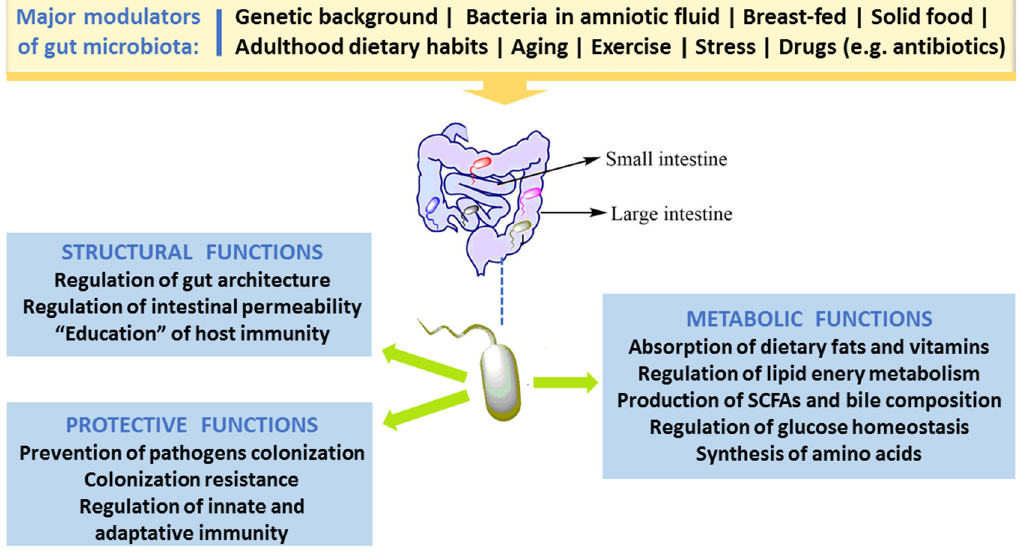
Figure 1. Major factors that modulate gut microbiota and key roles in humans.